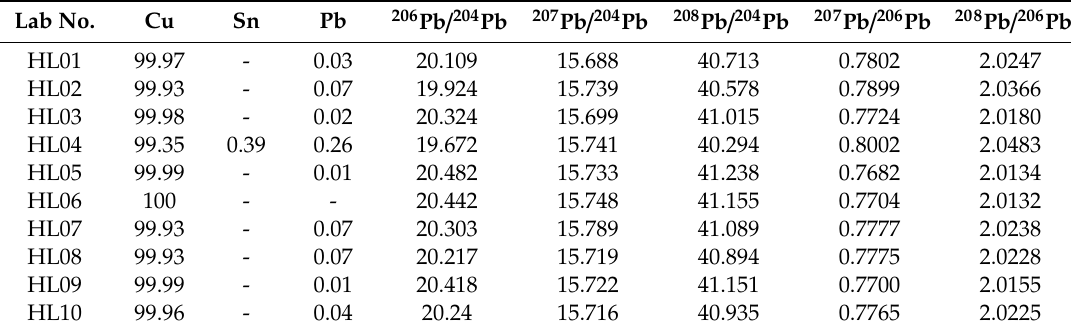
Table 1. Composition and lead isotope ratios of the spearheads of Huili. Lab